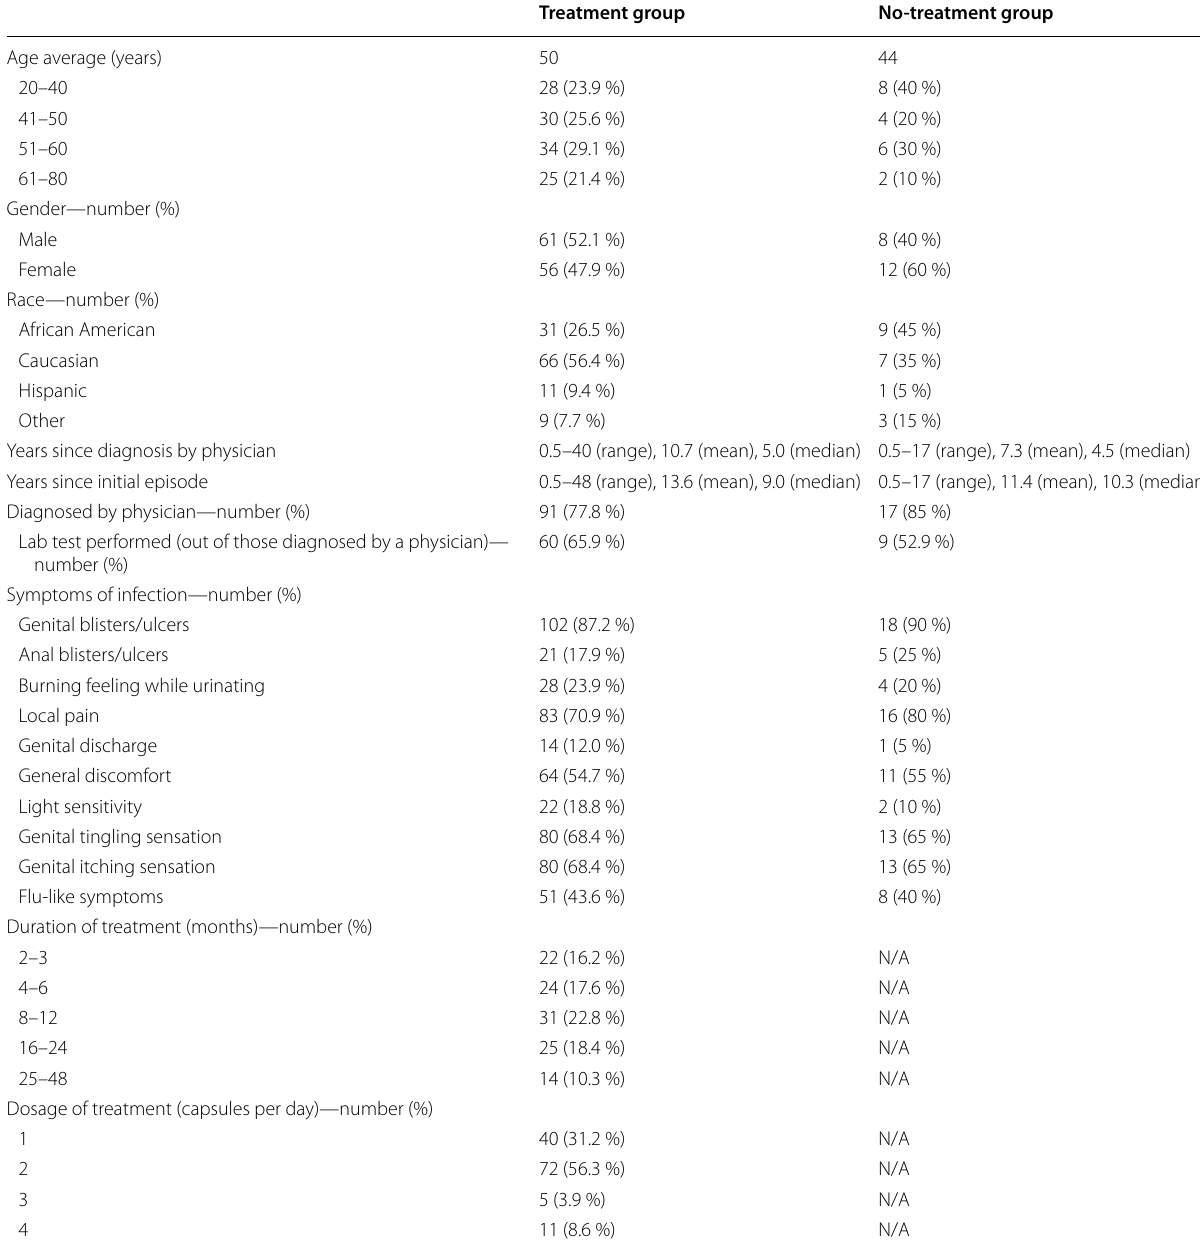
Table 1 Demographics and clinical